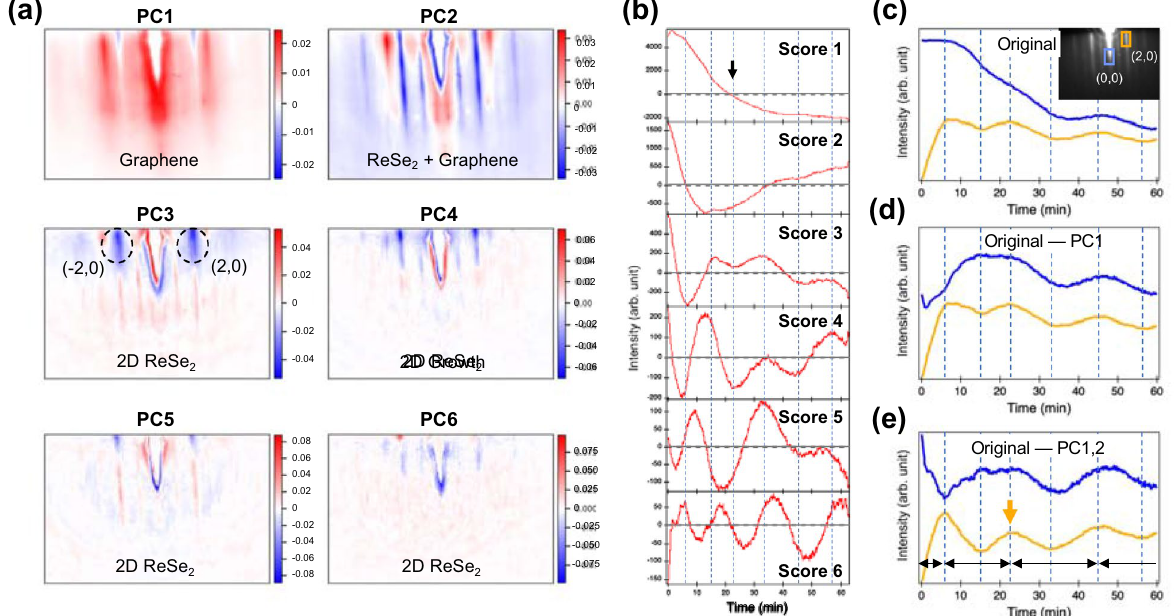
Fig. 3 PCA results; a Six PCs of the RHEED video for the 3UC‑thick ReSe 2 thin film and b the corresponding score plots. Component 1 (PC1) shows the diffraction signal of graphene, while component 2 (PC2) contains the signals of both the graphene and ReSe 2 layers. Component 3–6 (PC3‑6) show the signal of only the 2D growth of ReSe 2 layer. c – e The intensity plots of the ( c ) original RHEED video and d , e modified RHEED video. Blue and orange lines denote the (0,0) and (2,0) diffraction streaks of the ReSe 2 thin film (shown in the inset),